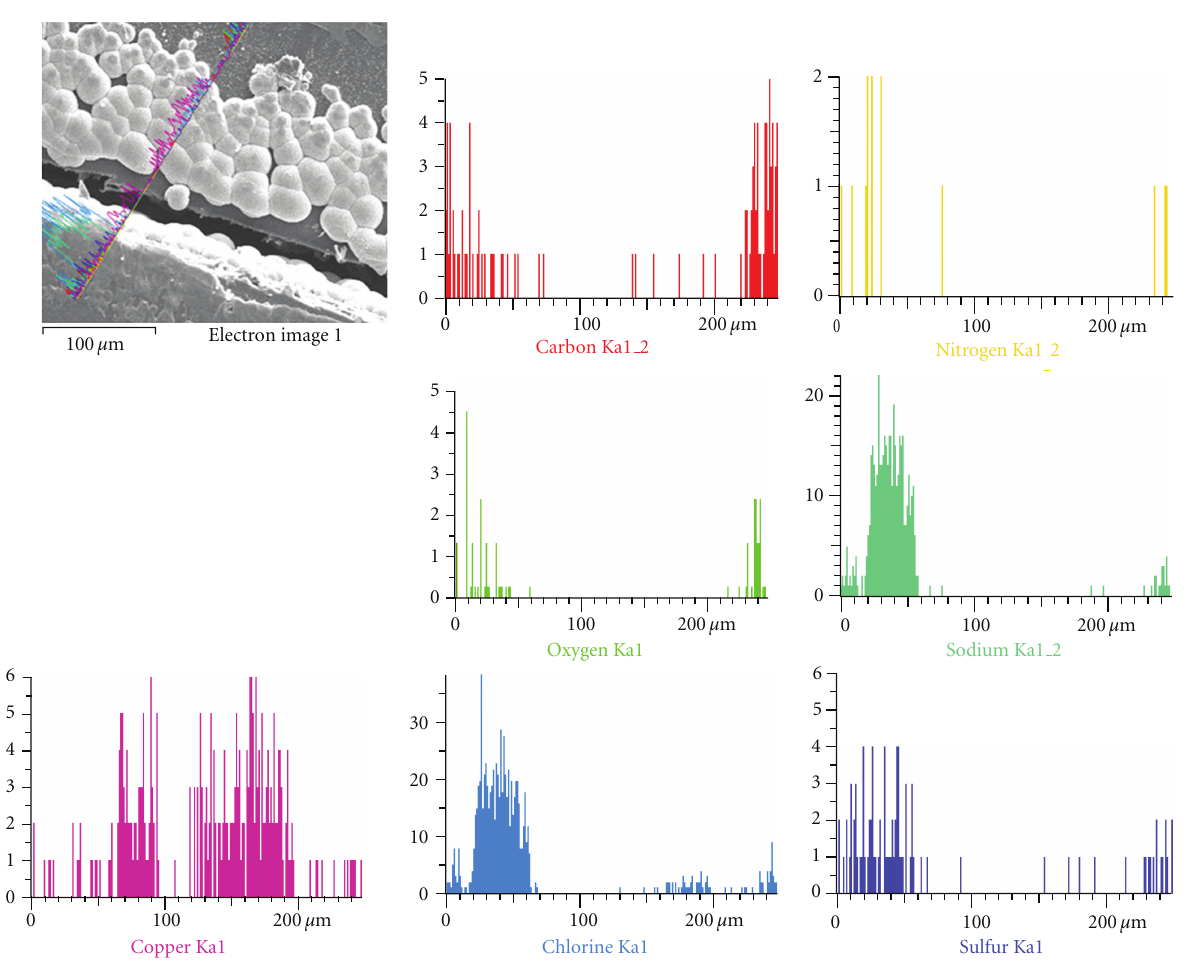
Figure 10: SEM micrograph and elemental analysis in the coating artificially damaged